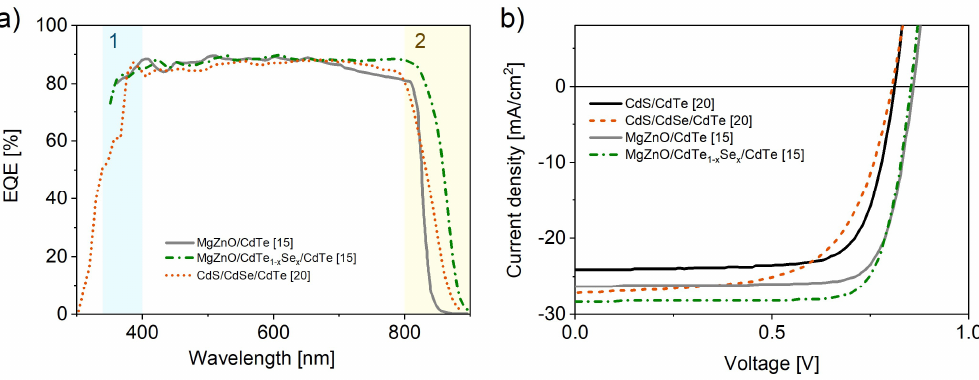
/ CdTe and MgZnO / CdTe / CdTe devices 1 − x Se x